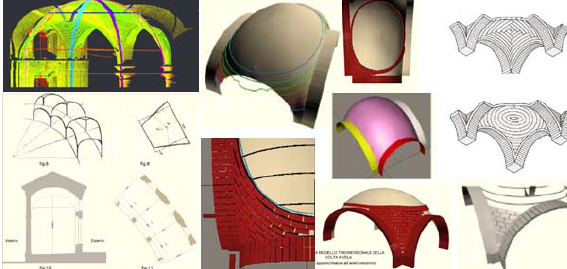
Figure 3. In the methodological path is reconstructed the geometry of the vault inscribed within the trapezium and the result of an ovoid non spherical shape. The 3D HBIM was generated from laser scanner vertical and horizontal slices, and the hypothesized texture of the brick block